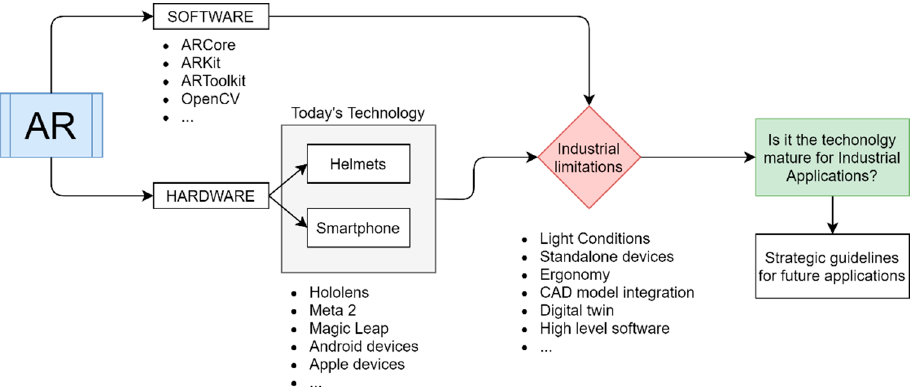
Figure 3. Workflow of paper methodology starting from existing technology applied to industrial application for strategic guidelines